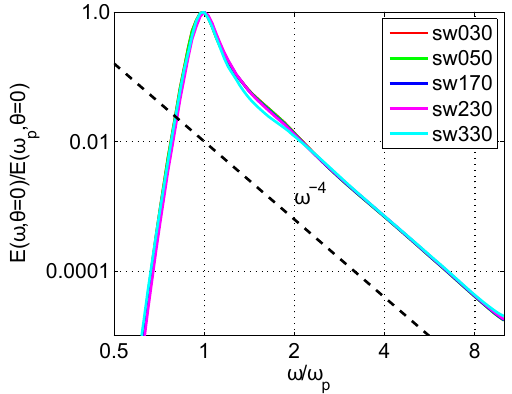
Figure 5. Normalized dependence of swell energy spectra on an- gle at peak frequency ω p after 11.5 days (approximately 10 6 s) of swell evolution for the runs of Table 1 (see the legend). Dashed line – Gaussian distribution (Eq. 29) with dispersion σ (cid:50) = 35 ◦ ; dotted line – growing sea (Eq. 30) and Eq. 9.1–9.2 of Donelan et al. (1985); dashed line – wrapped-normal fit of Ewans et al. (2004, Table 11.2, Fig.